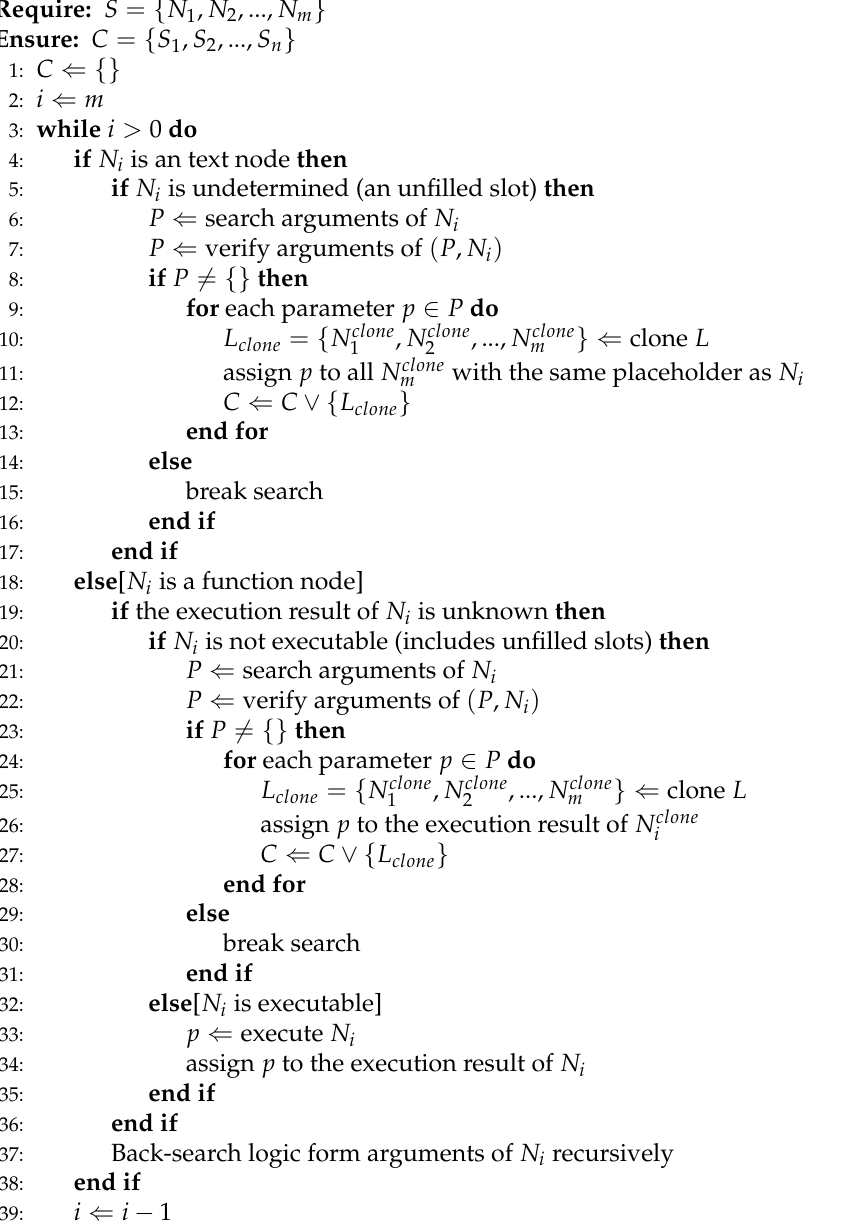
Algorithm 1 Back-search logic form